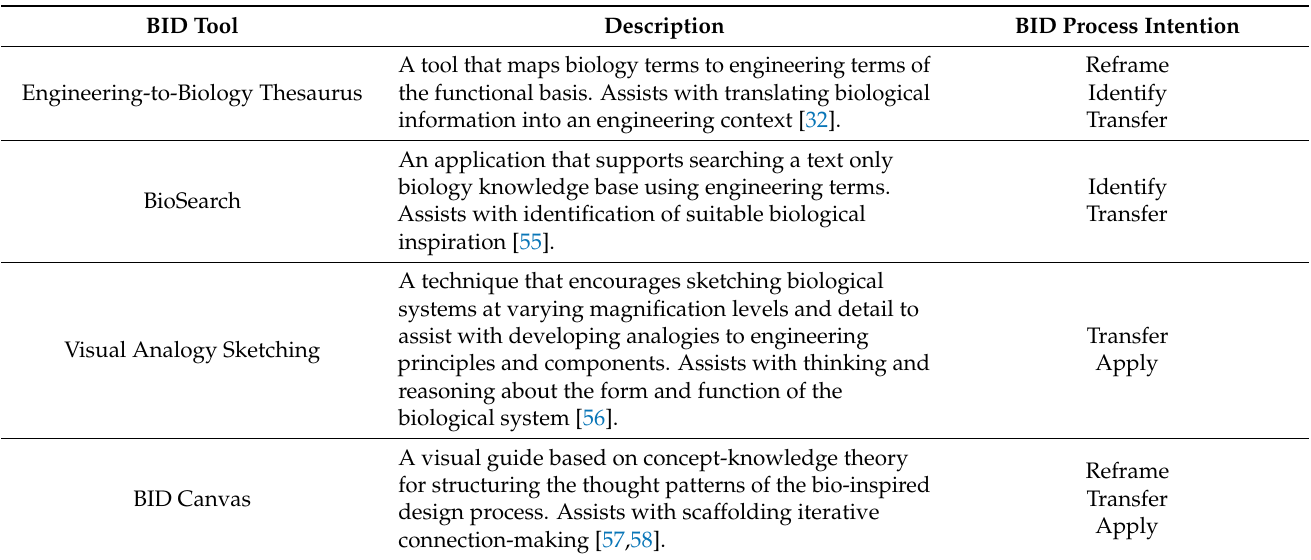
Table 1. Summary of BID Tools used in the training.